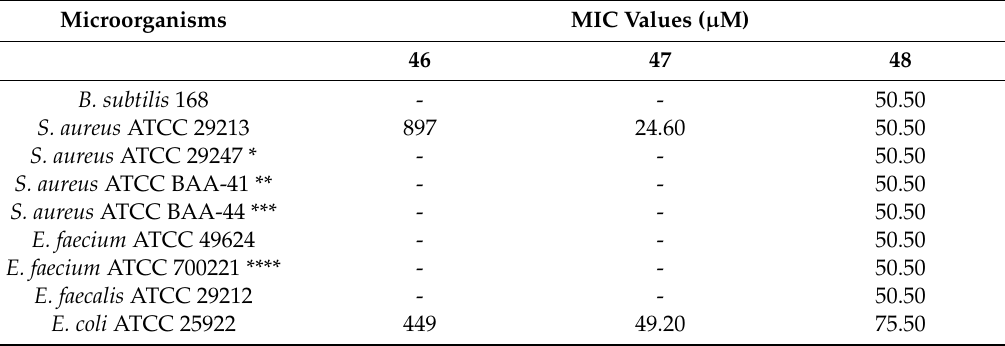
Figure 9. Chemical structures of the quinuclidine derivatives. Table 7. Minimum inhibitory concentrations of the quinuclidine analogues.